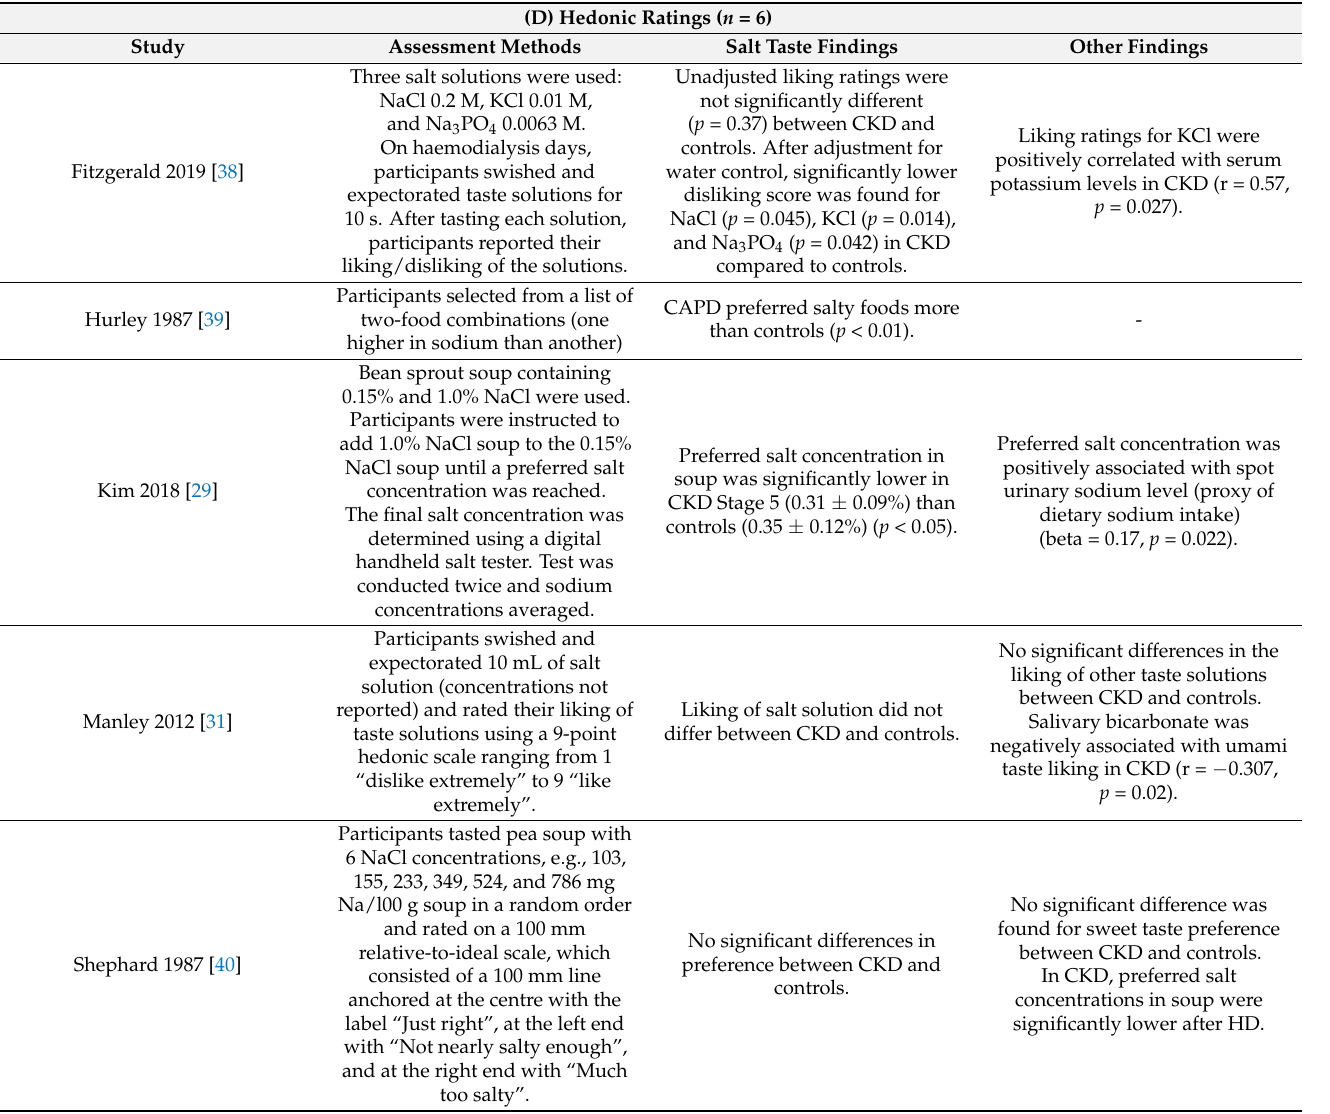
Table 3. Cont. (D) Hedonic Ratings ( n = 6) Assessment Methods Salt Taste Findings Other